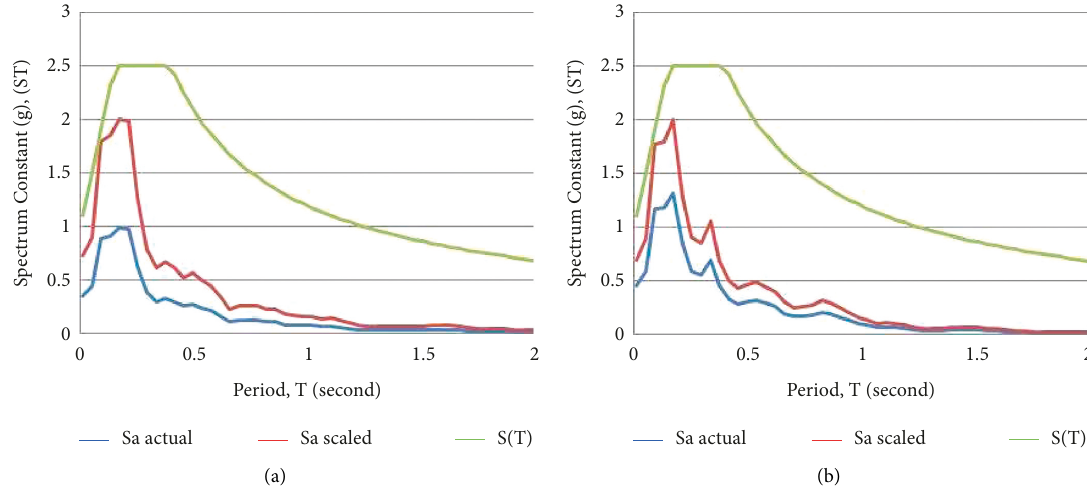
Figure 22: Evaluation of S(T) spectrum constants at Nevsehir station for (a) North-South (N-S) and (b) East-West (E-W) components of earthquake with epicenter at Nigde-Camardi ( M L : 4.3).